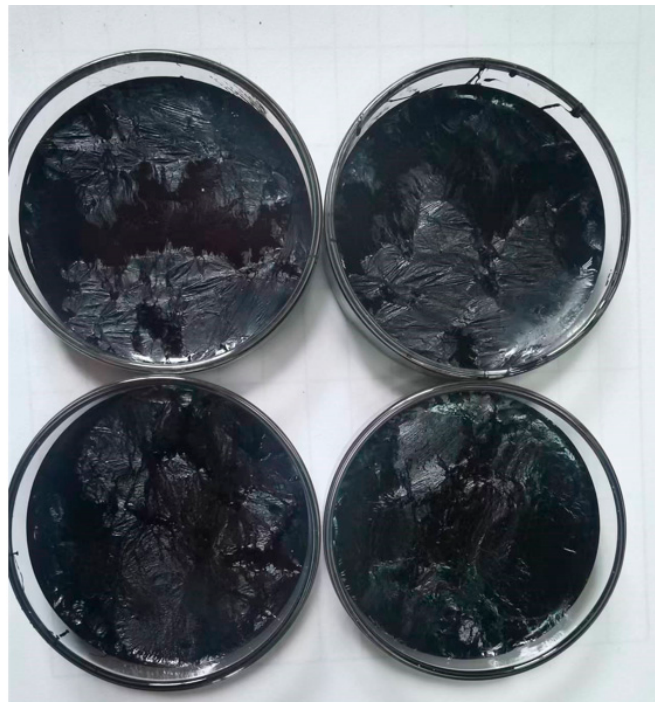
Figure 3. asphalt after UV aging. Figure 3. Asphalt after UV